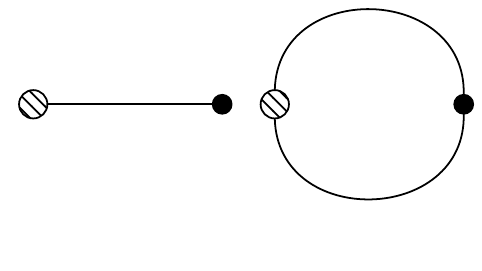
Figure 15 . Zero-mode contributions for the dynamical